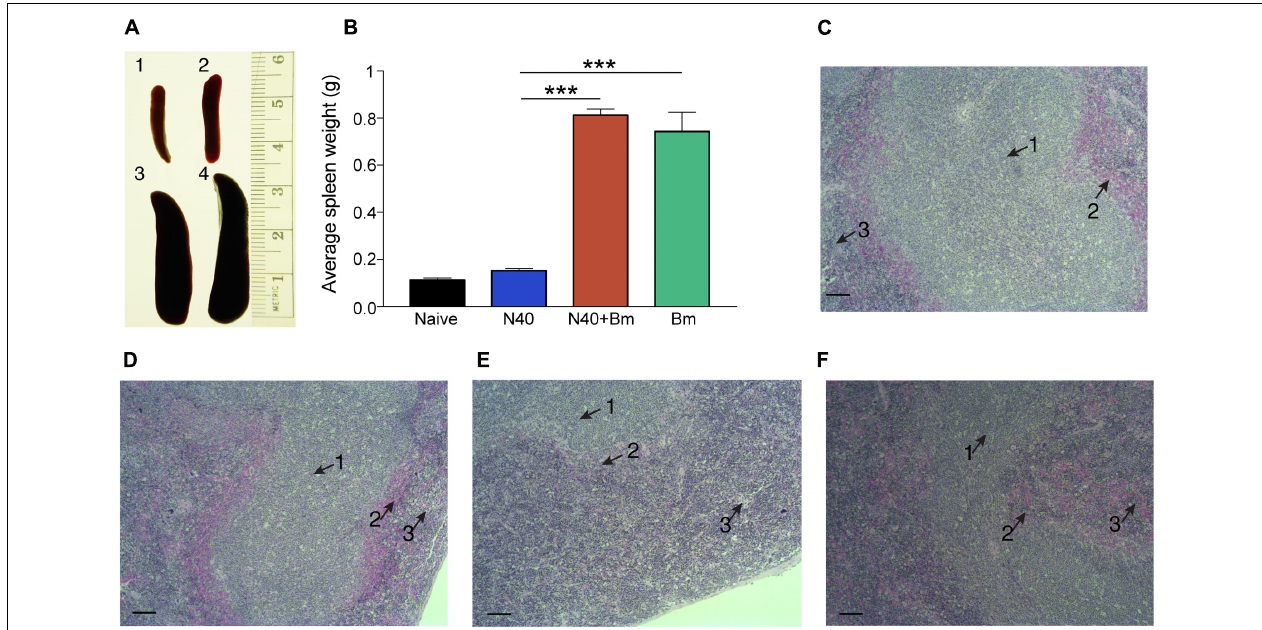
FIGURE 5 | Babesia microti ( Bm ) infection caused pronounced splenomegaly affecting splenic architecture in C3H mice at day 21 p.i. (A,B) A significant but moderate increase in spleen size is observed in N40 infected mice (2) compared to naïve mice (1) while very pronounced splenomegaly is observed in Bm infected (3) mice ( ∗∗∗ p < 0.001, df = 3, F = NA) and co-infected (4) mice ( ∗∗∗ p < 0.001, df = 5, F = NA). (C,D) H&E stained spleen sections displayed normal architecture with a clear demarcation between the white and red pulp (arrows 1 and 3, respectively) and marginal zone (arrow 2), in uninfected (C) , and N40-infected (D) mice. (E,F) Demarcation between red and white pulp was indistinguishable in spleens of co-infected (E) , and B. microti infected (F) mice. Bar in microscopic images represents 100 µ